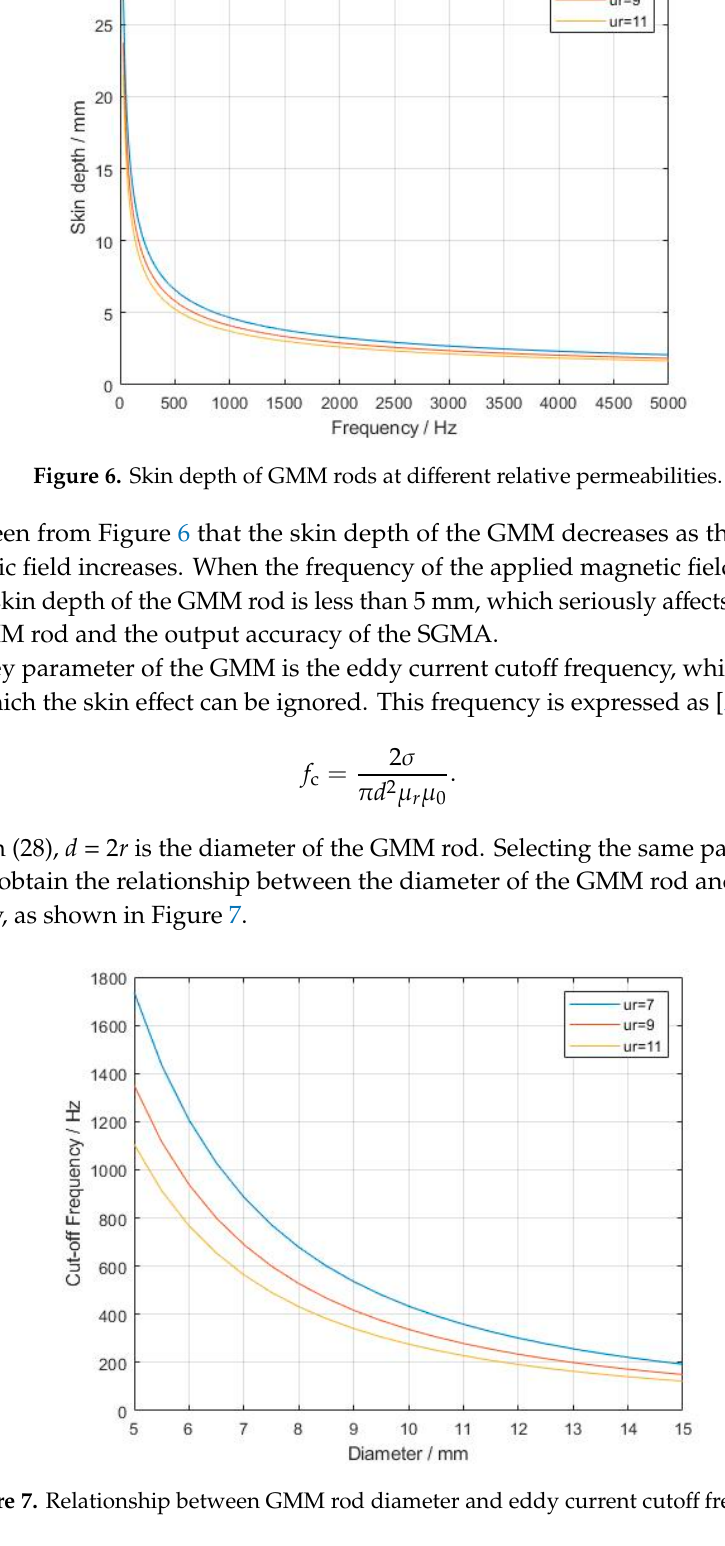
Figure 7. Relationship between GMM rod diameter and eddy current cutoff frequency.